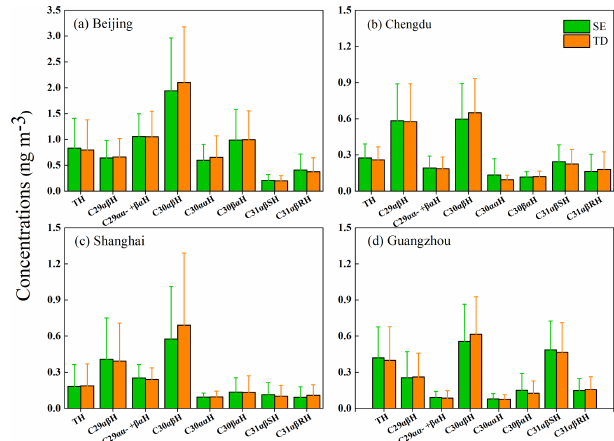
Figure 6. Average concentration of individual hopanes determined by SE-GC-MS and TD-GC-MS methods during wintertime from December 2013 to January 2014 in Beijing (a) , Chengdu (b) , Shanghai (c) and Guangzhou (d) . Error bar is one standard devi- ation of individual